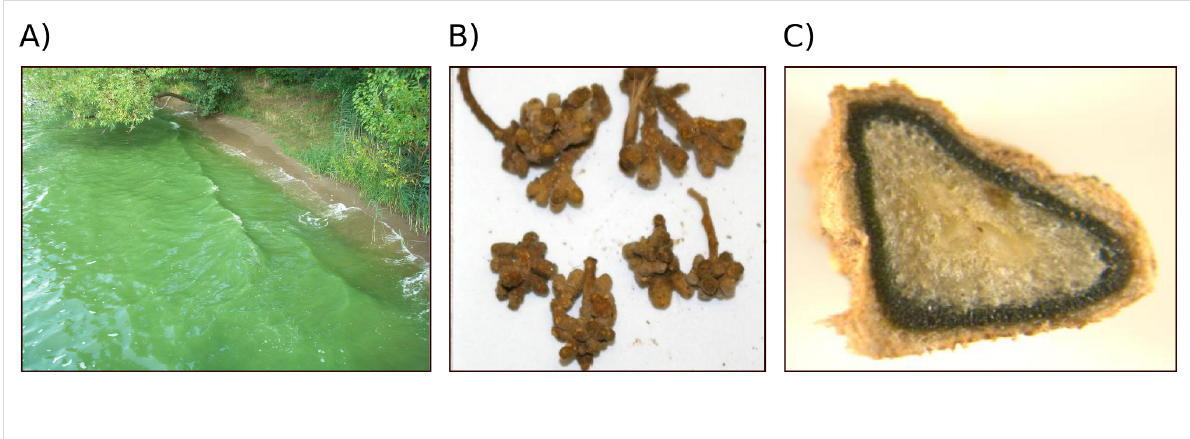
Figure 1: Cyanobacteria proliferate in diverse habitats. A) Bloom-forming freshwater cyanobacteria of the genus Microcystis . B) Roots of cyanobacte- rial symbiosis host Cycas circinalis . C) Terrestrial cyanobacteria living in corraloid roots of Cycas circinalis .